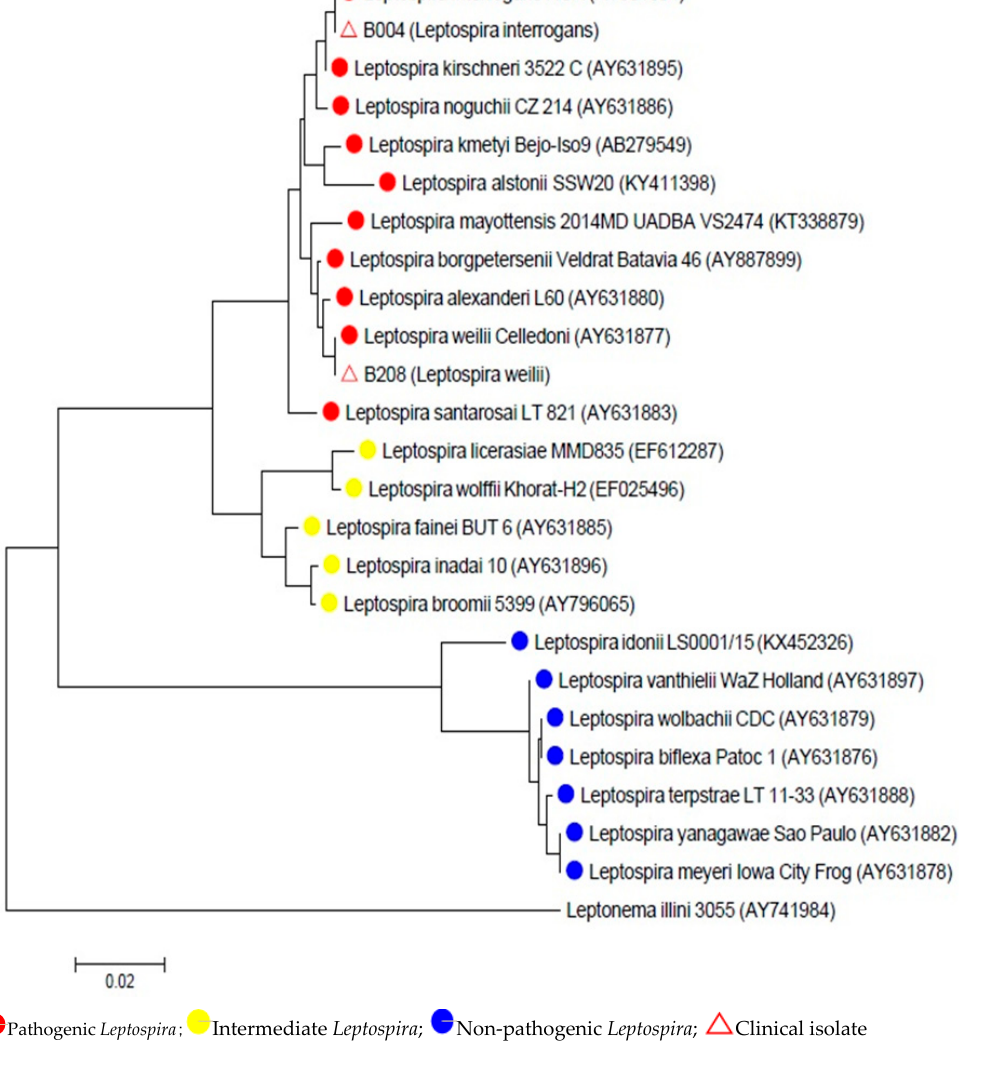
Figure 2. This phylogenetic tree showing evolutionary relationships of taxa of Leptospira spp. and the analysis confirmed that B004 and B208 were within pathogenic